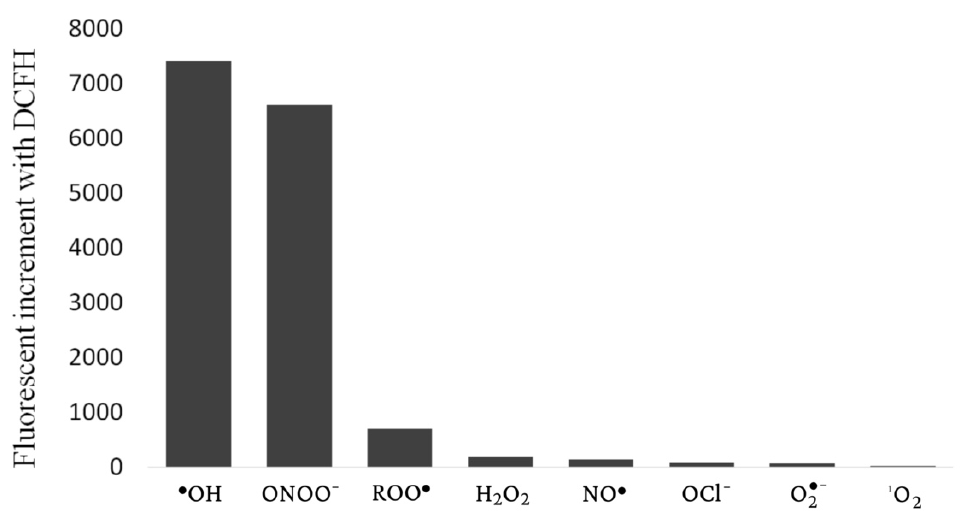
Figure 4. Relative oxidative potential of some bio-oxidants from [73].